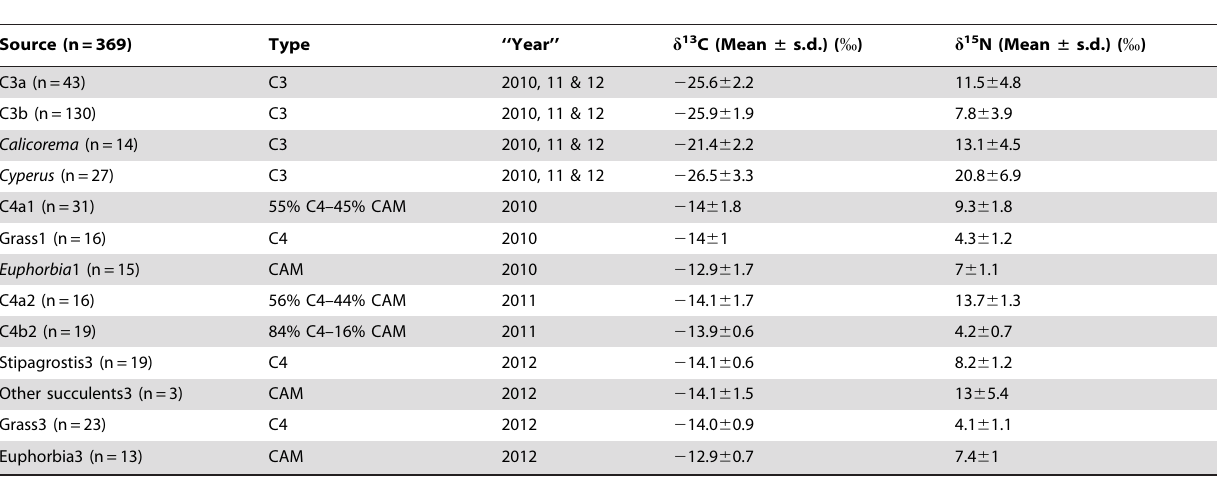
Table 1. Summary of the Mean 6 s.d. values of d 13 C and d 15 N for thirteen food sources.